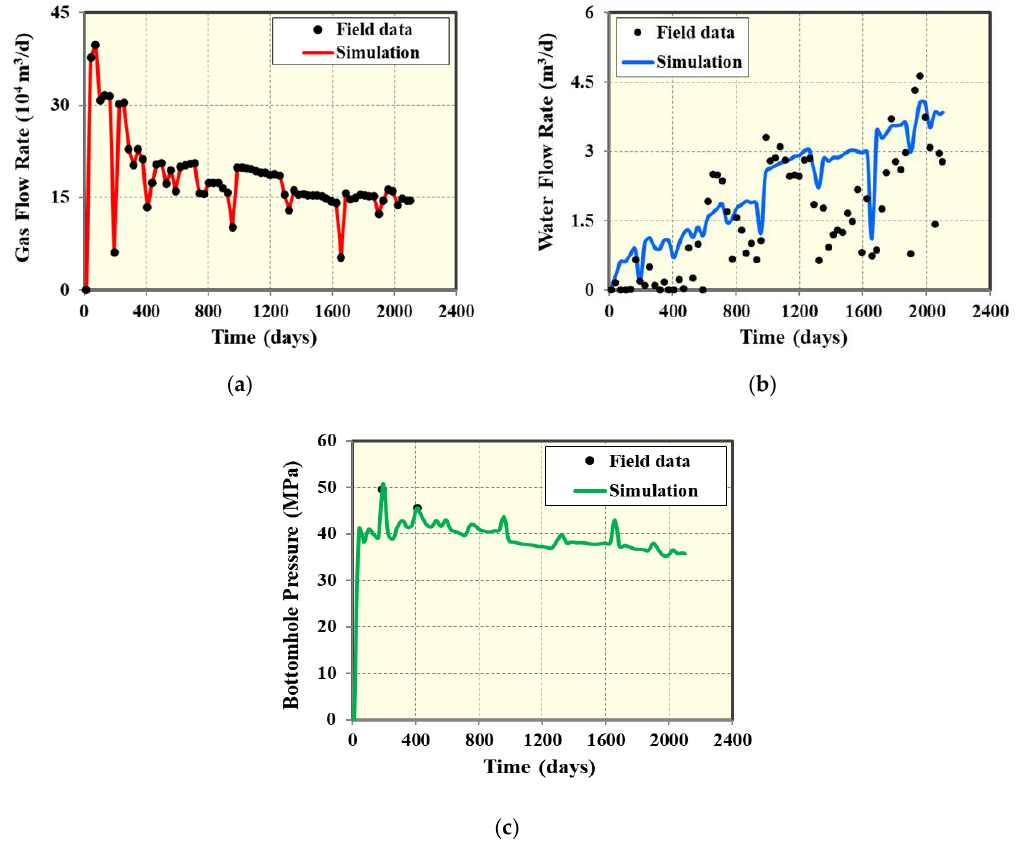
Figure 31. Single-well model simulation and history matching results of well B5. The points represent the field data while the solid lines represent the simulated values: ( a ) gas flow rate history matching results; ( b ) water flow rate history matching results; ( c ) BHP history matching results.